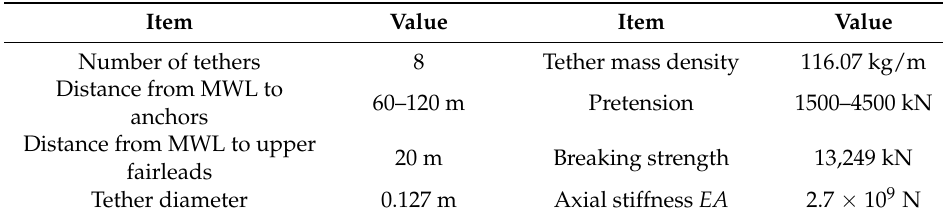
Table 3. Mooring system principal